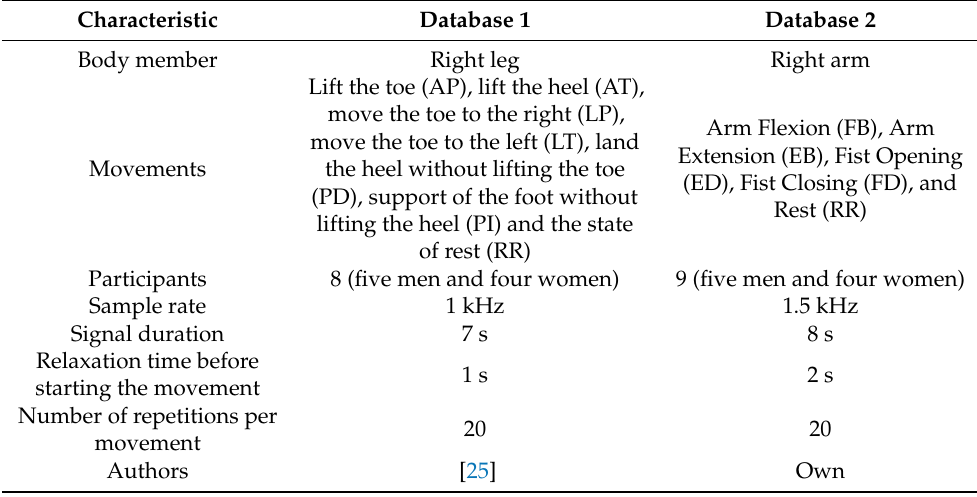
Table 2. General characteristics of the implemented